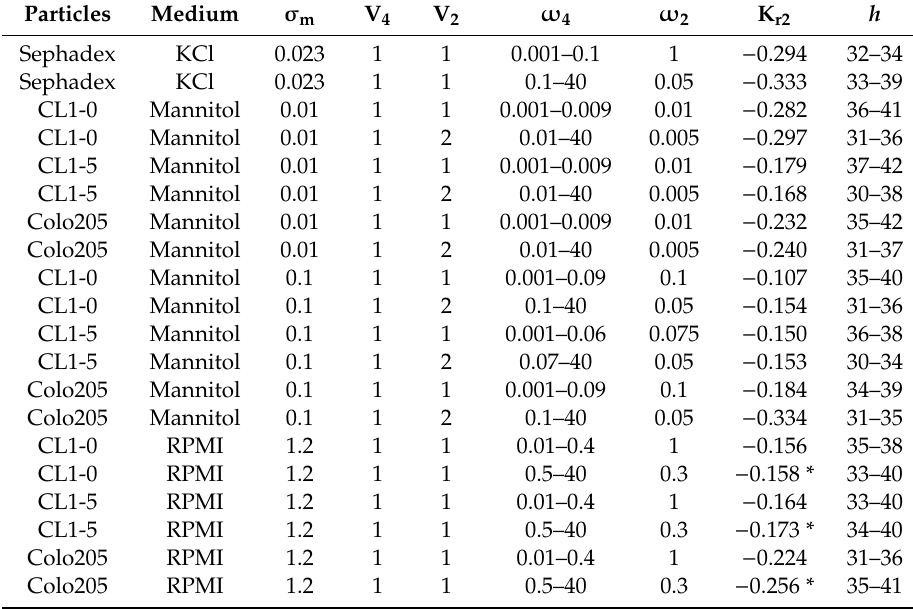
Table 1. Parameters in the electrorotation (ER) experiment with 8-electrodes under dual frequency operation. The units for σ m , V 4 (and V 2 ), ω 4 (and ω 2 ) and h are S / m, volt, MHz and µ m, respectively. The values of K r2 are adopted from Ref. [5]; those values with * are obtained through